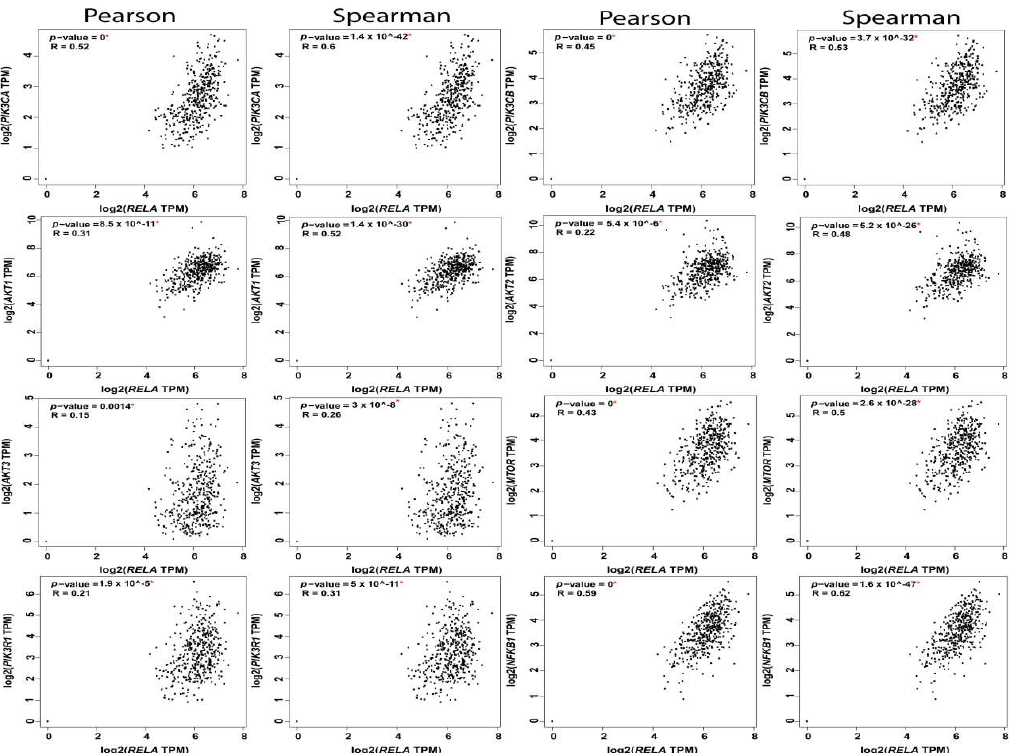
Cancers 2019 , 11 , x Figure 4. Correlation between RelA and the nodes of PI3K-AKT-mTOR and NFkB pathways.